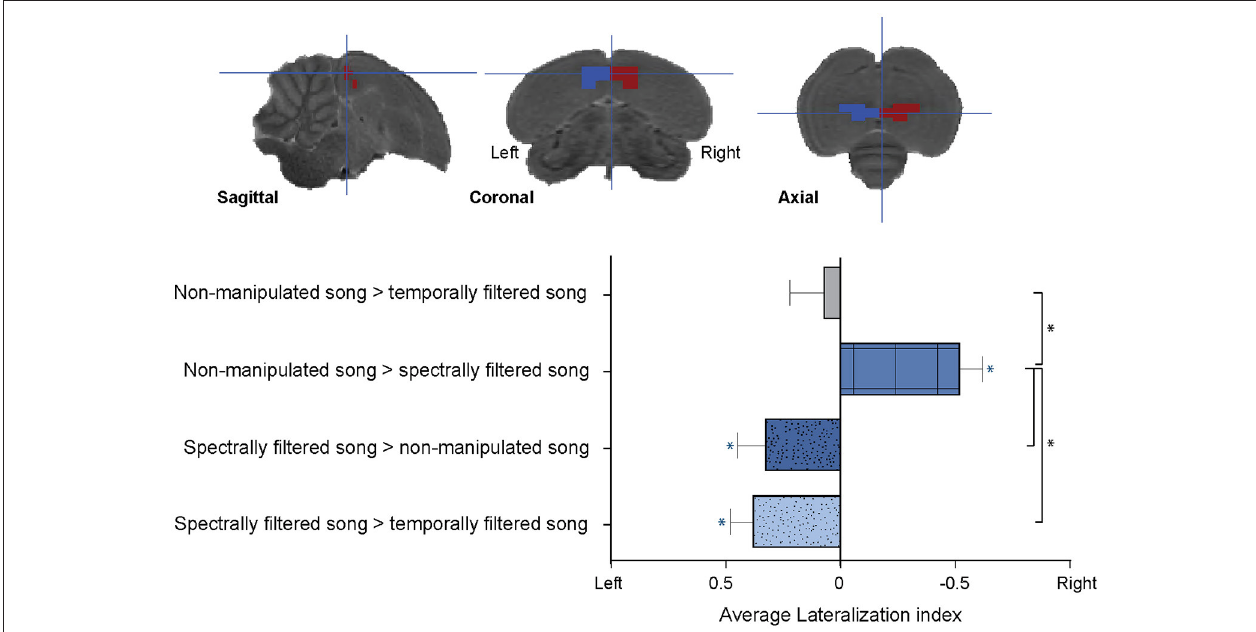
FIGURE 4 | Lateralization of the sensitivity to spectral and temporal filtering. (Top) Illustration of the left and right regions of interest for the lateralization analysis overlaid on sagittal, coronal, and axial slices from the population based template. (Bottom) Graph indicating the average lateralization index for the different filtering effects. The error bars represent the standard error of the mean across subjects. The blue asterisks indicate a significant lateralization of the respective effect to either the left or right (lateralization index significantly different from zero) (* p < 0.05; n =